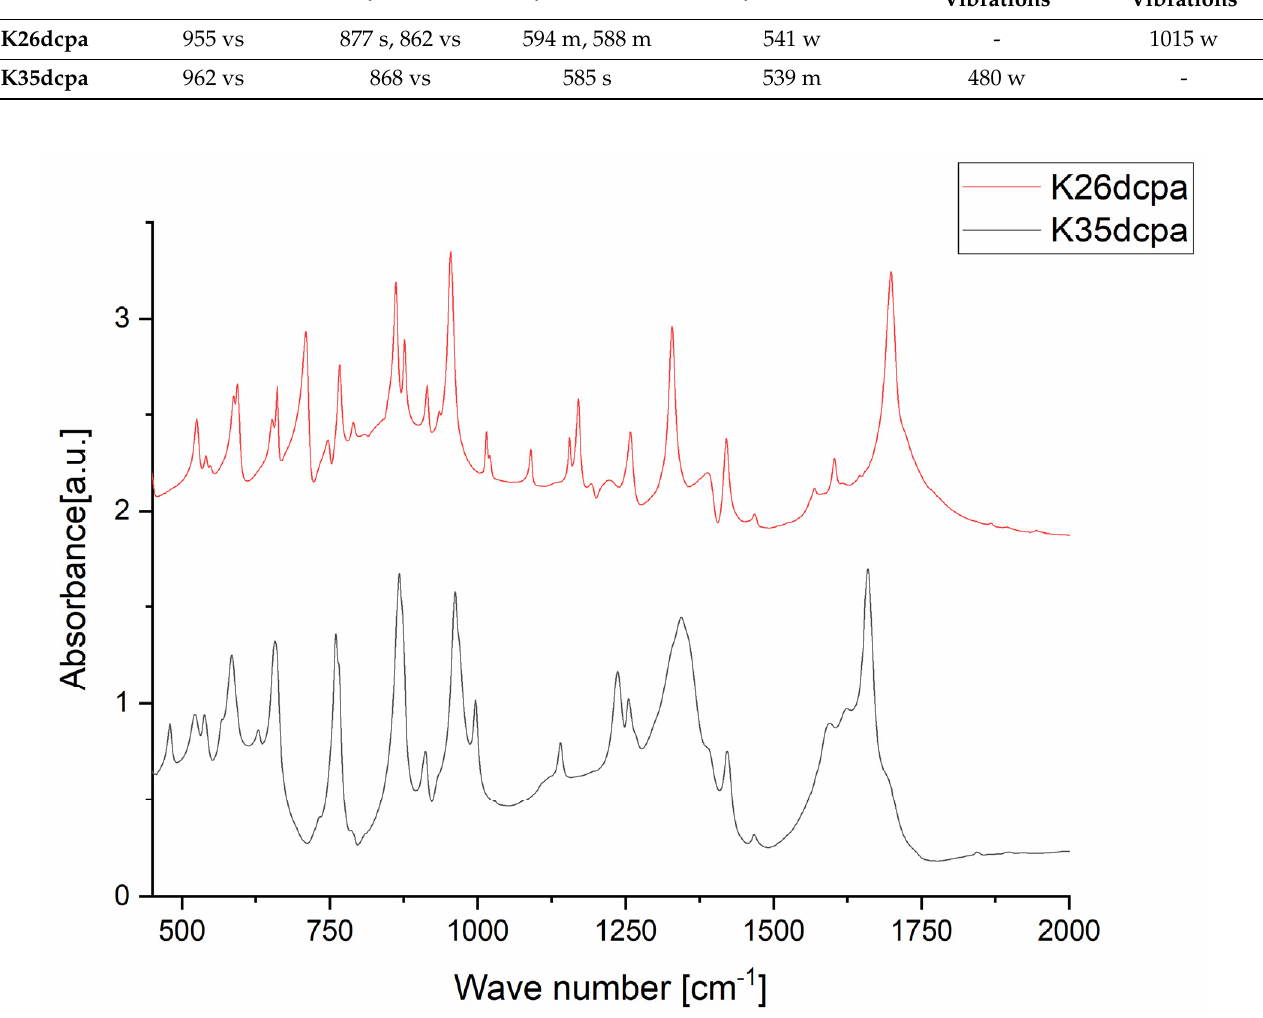
Figure 3. IR spectra of the compounds K26dcpa and K35dcpa . N-oxide and Mo-N vibrations listed in Table 3.